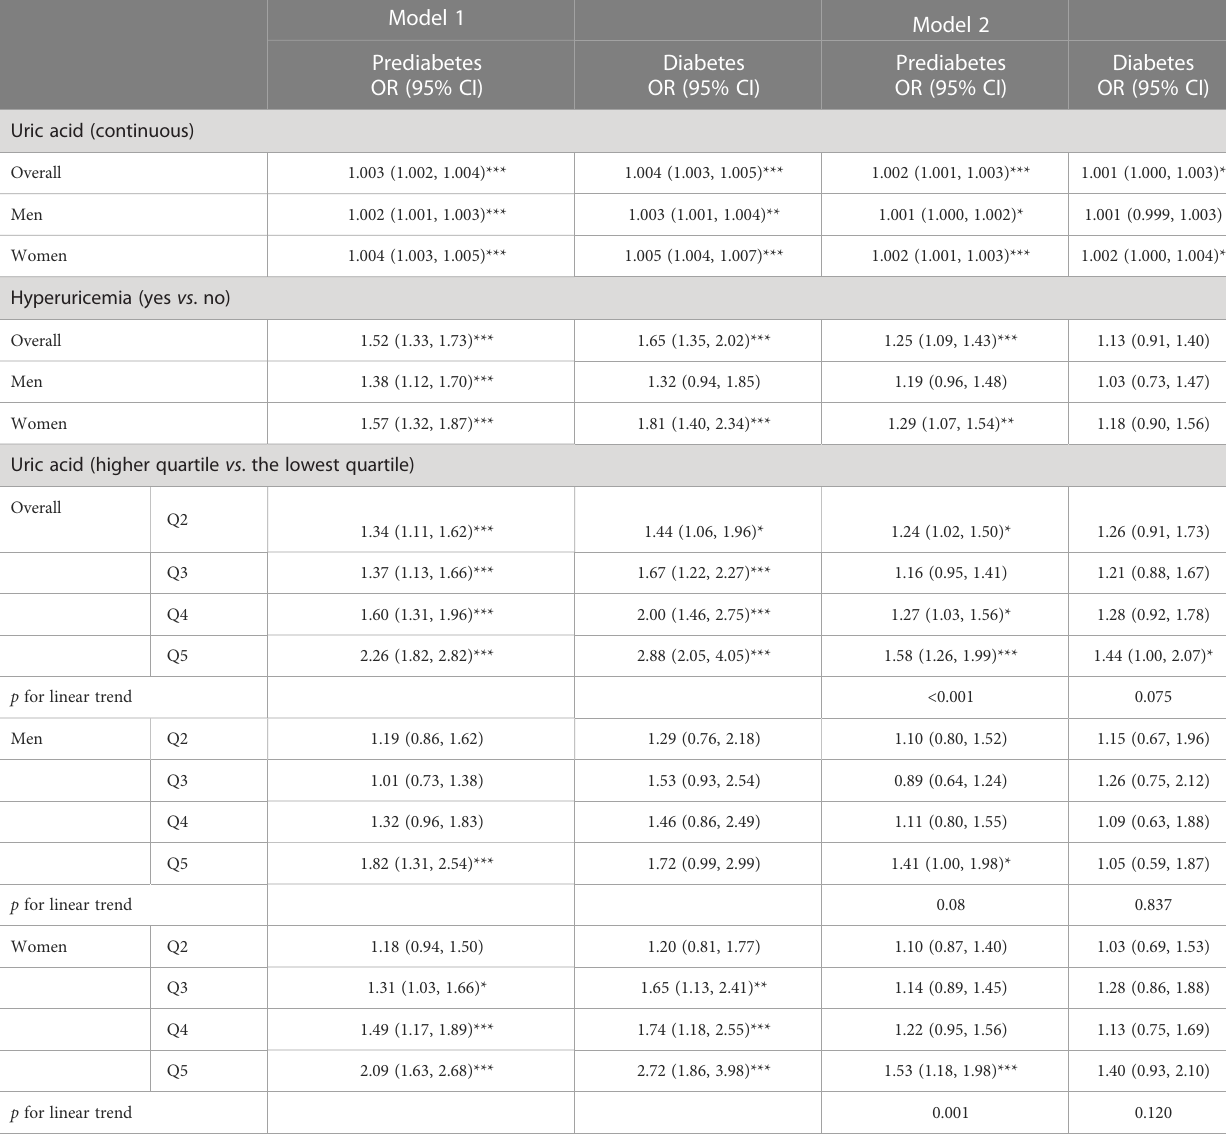
TABLE 2 Multinomial logistic analysis for prediabetes and diabetes risk in association with serum uric